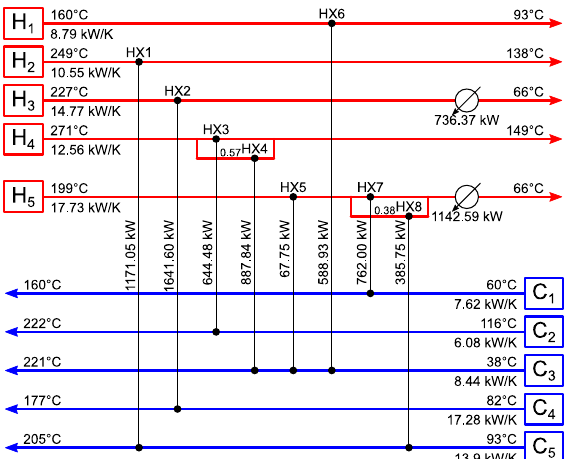
Figure 2. Grid-diagram representation of the optimal HEN configuration of example 1a (TAC: 42,963 $/yr).